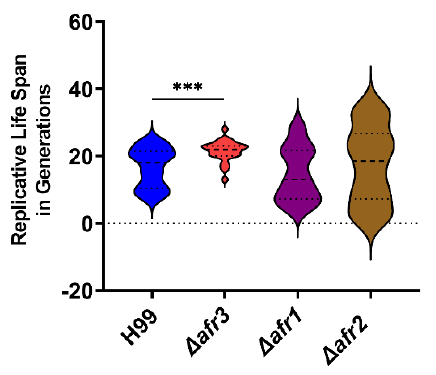
Figure 6. Afr3 Plays a Role in Aging. The C. neoformans ∆ afr3 mutant strain (red) has an expansion of the median lifespan compared to the H99 wild-type strain (blue), while ∆ afr1 (purple) and ∆ afr2 (brown) mutant strains do not show significant difference. Statistical analysis was performed with Student’s t-test, *** p < 0.001.